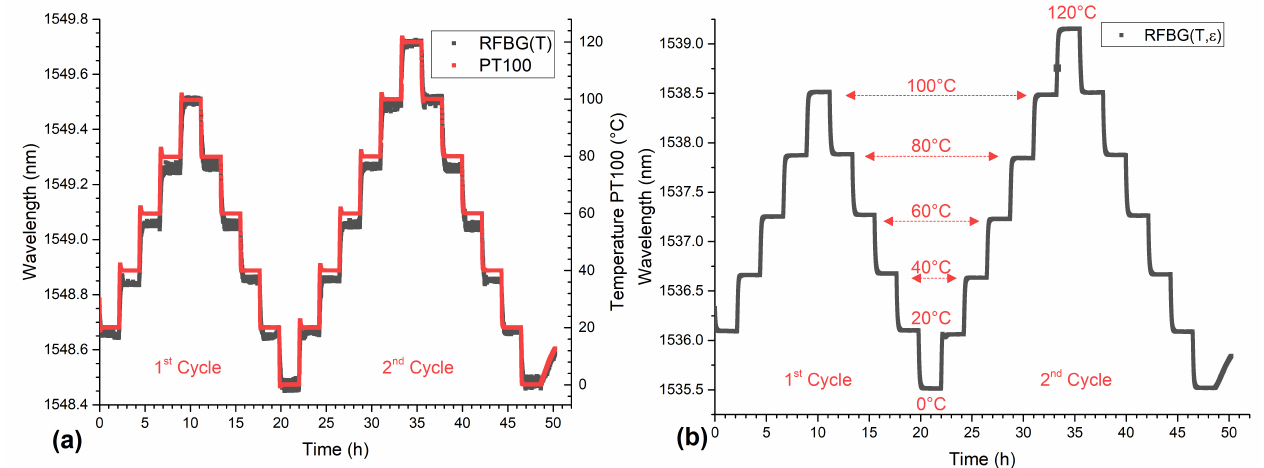
Figure 13. ( a ) The Bragg wavelength of the RFBG-based temperature sensor and the Pt100 temperature data as a functions of time. Both sensors followed the temperature of the chamber, the Pt100 with no and the RFBG with little delay. ( b ) The Bragg wavelengths as a function of time of the embedded strain sensor(RFBG(T, ε )). The wavelengths of the embedded strain sensor showed larger shifts compared to the temperature sensor due to thermal strain of the aluminum acting additionally on the fiber.